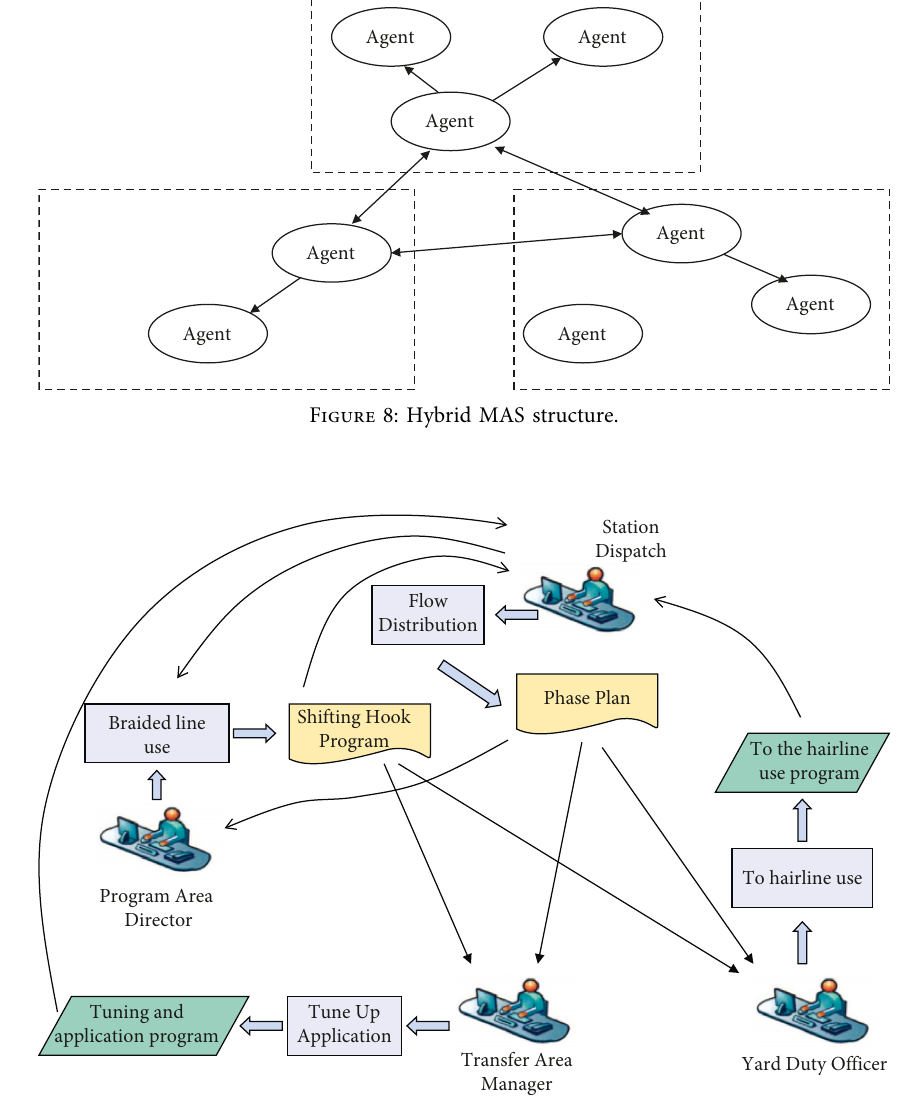
Figure 9: Collaborative relationships in the organization of railroad transport.